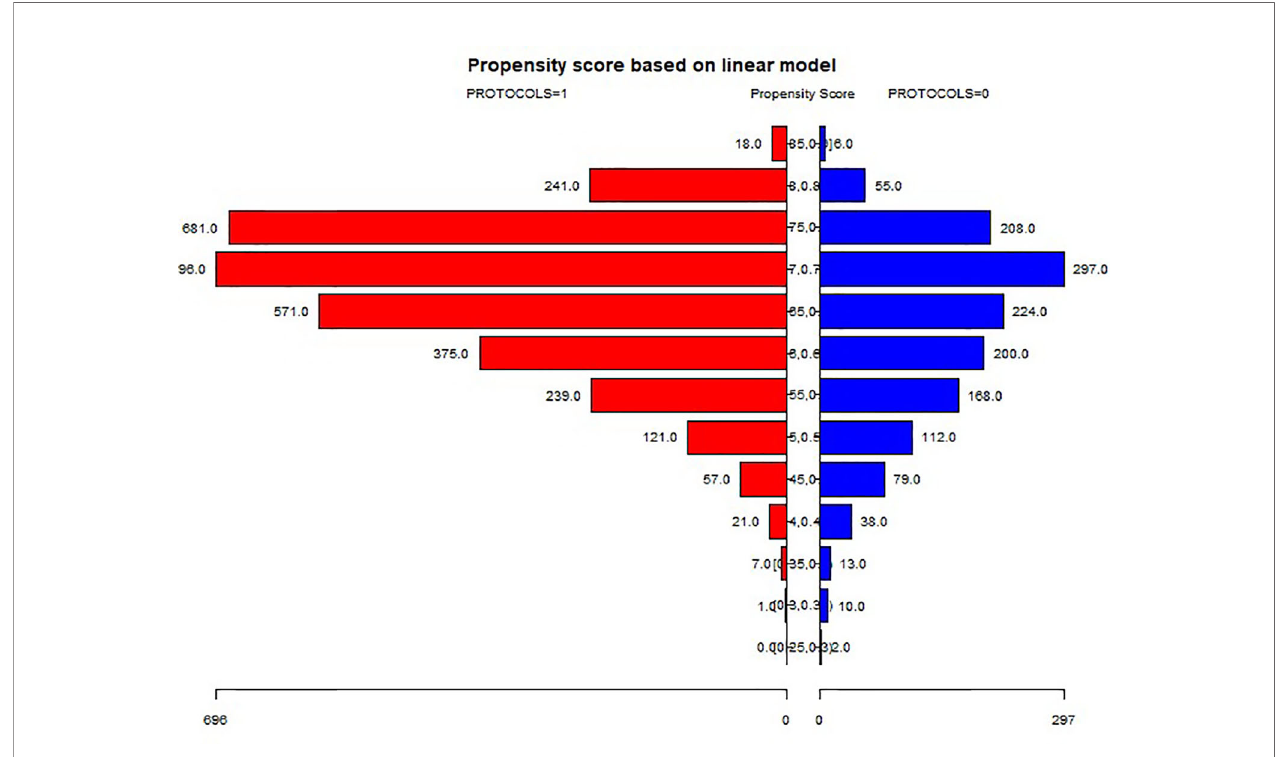
FIGURE 2 | Propensity score matching of the two protocols.